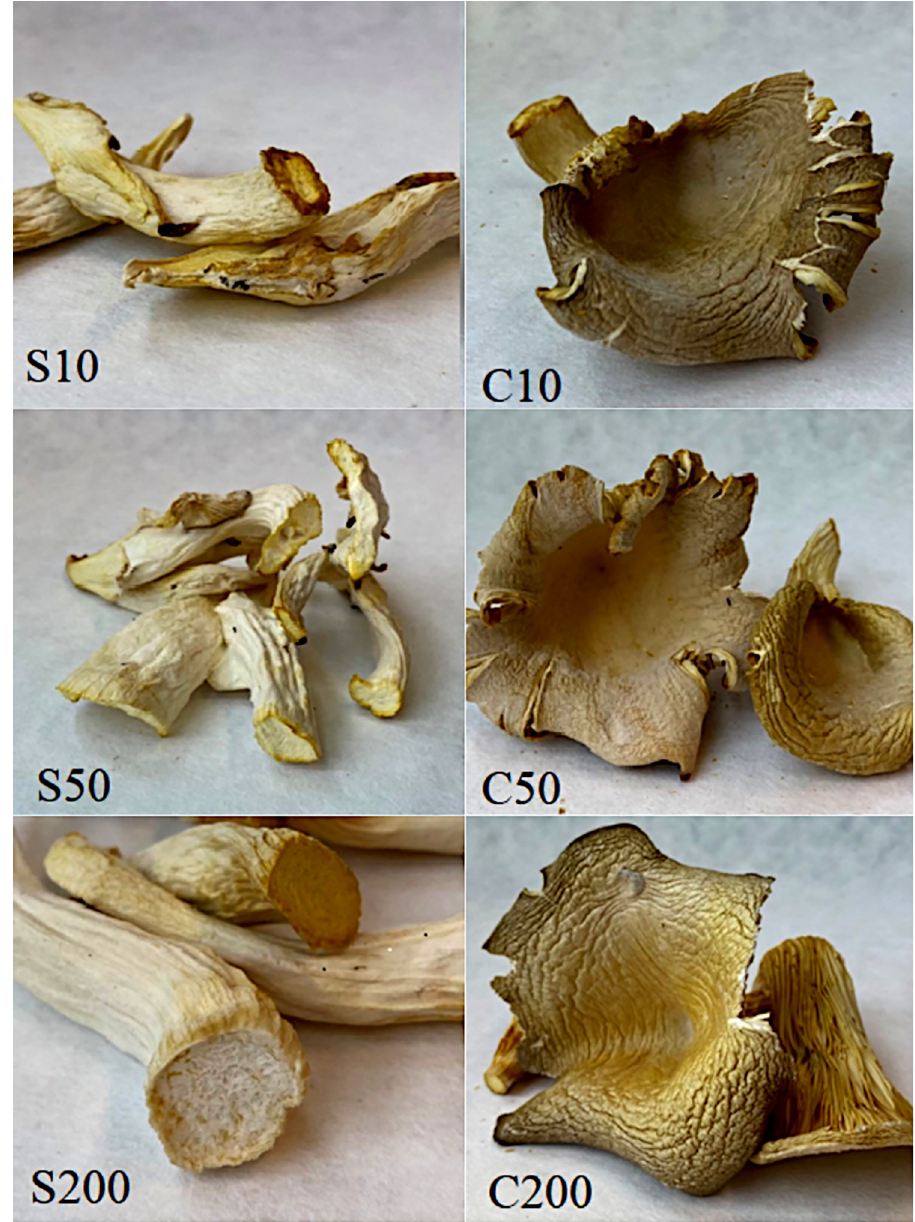
Fig 1. Photo of the fruiting bodies of the oyster mushroom cultivated in the test conditions by anatomical part. Legend: C200 is the fraction of the cap maturing at 200 lux, S200 marks of the stem maturing at 200 lux. C50 and S50 are the caps and stems of fruiting bodies maturing at 50 lux. The C10 and S10 cap and stem fractions matured under 10 lux lighting conditions.